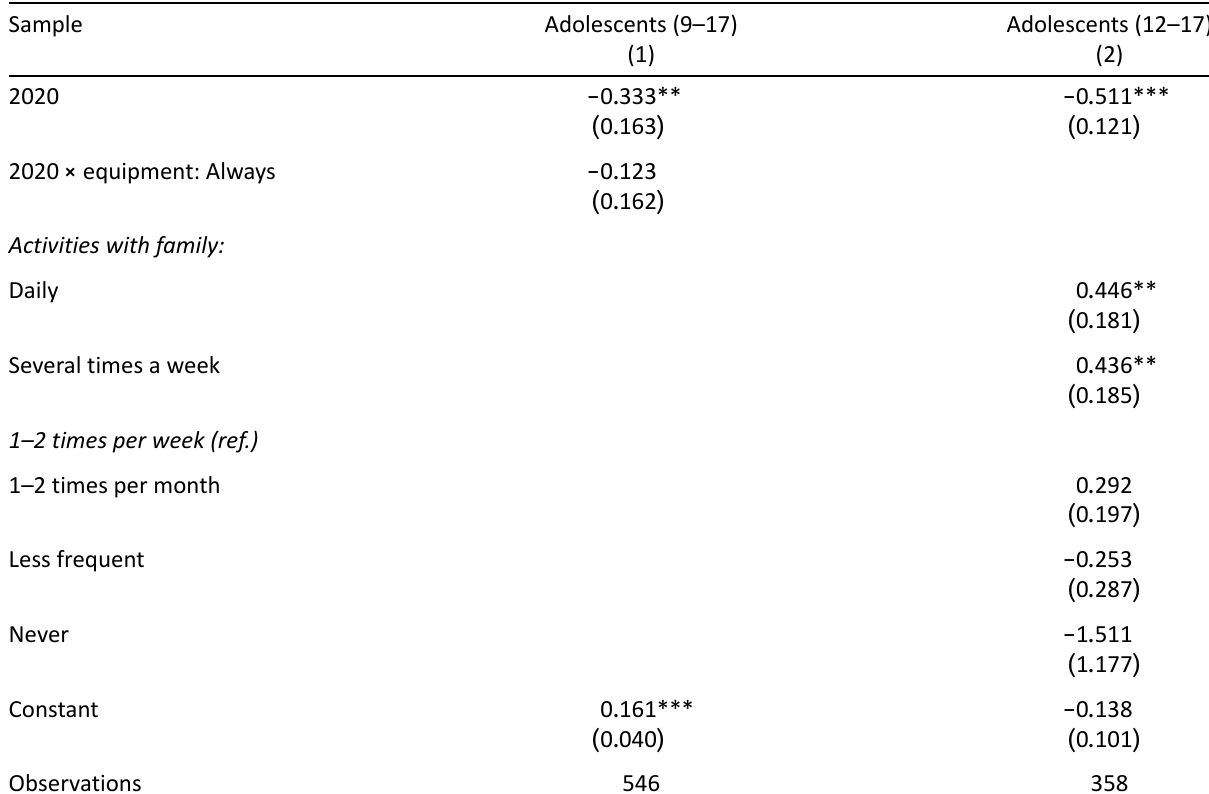
Table 4. Changes in adolescents’ perception of family climate by equipment and activities with family.